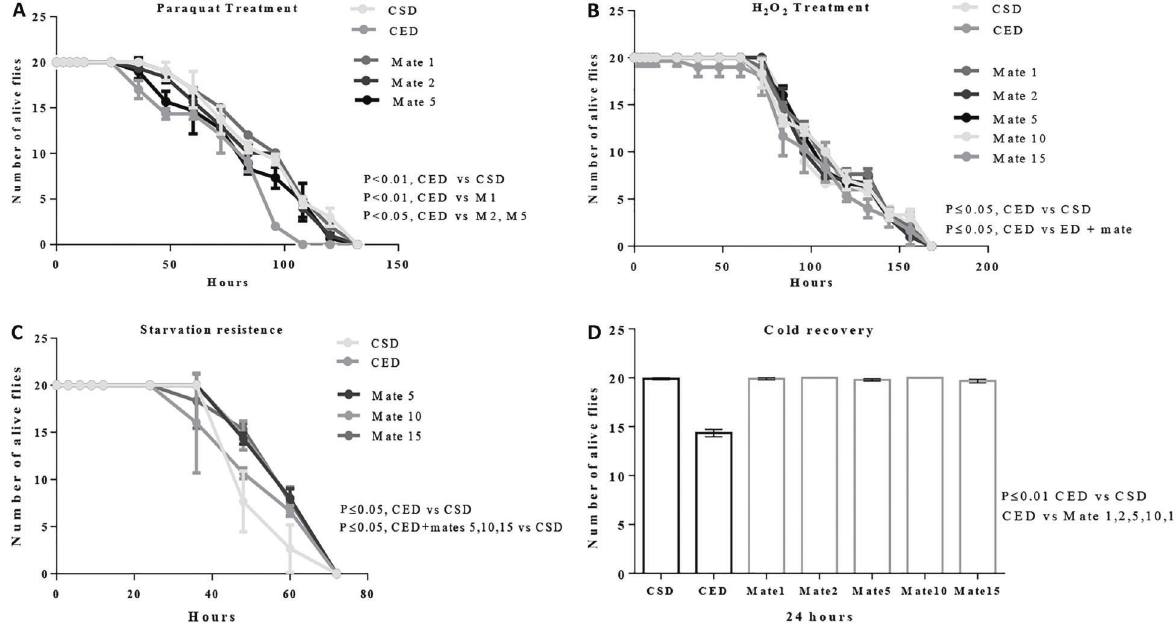
Figure 5 . Experimental paradigm for fl ies ’ resistance to paraquat treatment ( A ), hydrogen peroxide treatment ( B ), starvation ( C ) and cold recovery ( D ). Flies were placed on control standard diet (CSD), control experimental diet (CED), or experimental diet + mates (M1, M2, M5, M10, M15) for 10 days. They were then submitted to the tests (Shapiro-Wilk and ANOVA followed by the Dunnett ’ s